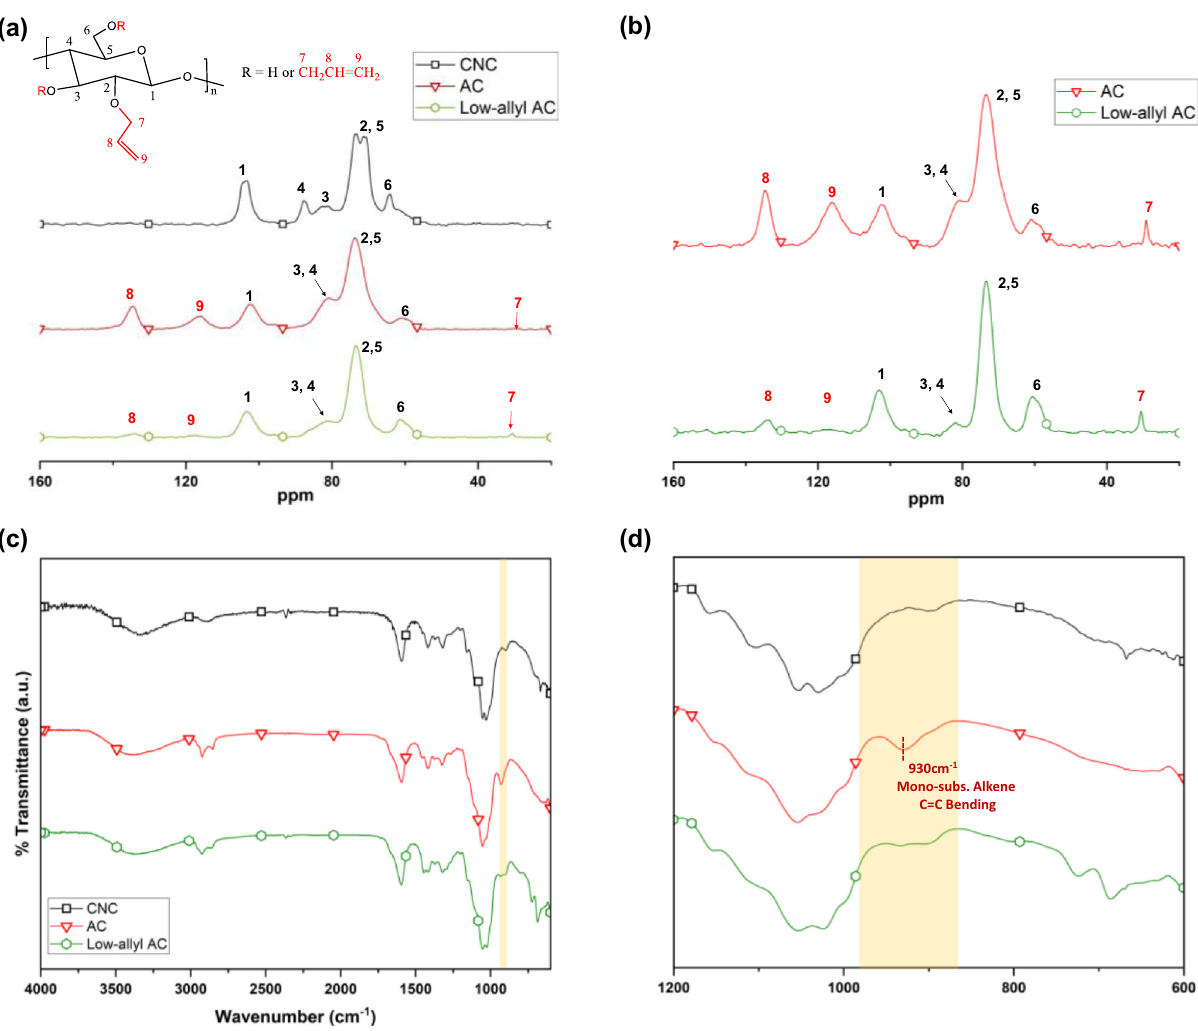
Fig. 1 Preparation of allyl-functionalized cellulose nanocrystals of varying % allylation. a Solid-state 13 C CP-MAS NMR spectra of CNC, AC, and LAC. b 13 C solid IG-NMR of AC and LAC, and the assigned allyl-group carbon peaks. c The normalized ATR-FTIR spectra of CNC, AC and LAC. d A representation of robust allylation of CNC by the strong monosubstituted alkene C = C bending at 930 cm − 1 in